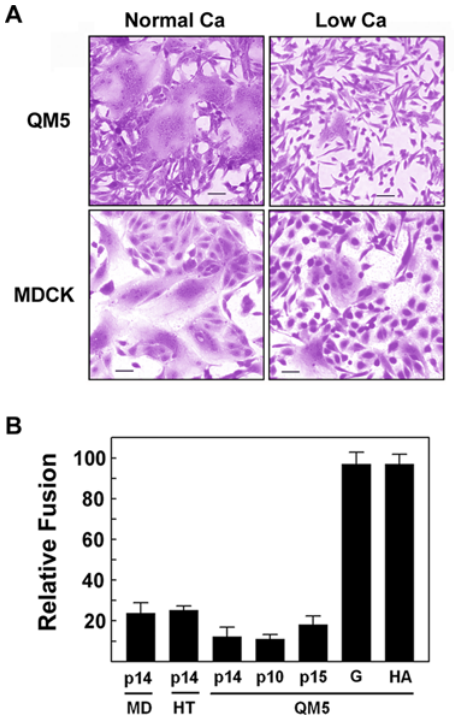
Figure 2. Calcium depletion inhibits FAST protein-mediated syncytiogenesis. (A) QM5 and MDCK cells were transfected with p14, cultured under normal or low calcium conditions, then fixed and Giemsa stained at 8 (QM5) or 20 (MDCK) h post-transfection to detect multinucleated syncytia. Scale bar=50 m m. (B) Influenza HA- (HA), VSV G- (G) and FAST protein (p10, p14, p15) -transfected QM5 fibroblasts, and p14-transfected MDCK (MD) or HT1080 (HT) epithelial cells were cultured under normal or low calcium conditions. Cells were fixed at various times post-transfection when syncytia were countable, and the average number of syncytial nuclei per field was determined from Giemsa-stained monolayers. Data is presented as the extent of cell fusion under low calcium conditions relative to the same transfected cells cultured for the same length of time under normal calcium conditions, set at 100%. Values represent the mean 6 S.E. (n=3). The following numbers are the average syncytial nuclei per field for the different fusogens in the different cell lines under normal calcium levels (i.e. the 100% level): p14 in MDCK cells, 20 h post-transfection - 81.2; p14 in HT1080 cells, 9 h post-transfection - 44.9; p14 in QM5 cells, 7 h post-transfection - 200.4; p10 in QM5 cells, 9 h post-transfection - 83.1; p15 in QM5 cells, 13 h post-transfection - 101.6; VSV-G protein in